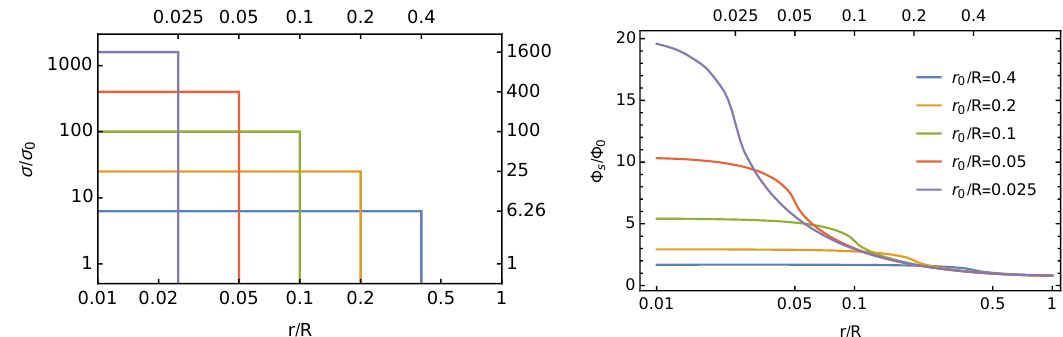
Figure 3. Scaled surface charge density σ ( r ) / σ 0 (left diagram) and scaled surface potential Φ s ( r ) / Φ 0 (right diagram) according to Equation (9), with l D = R and ε l = ε w . In both diagrams, the different curves correspond to r 0 / R = 0.4 (blue), r 0 / R = 0.2 (orange), r 0 / R = 0.1 (green), r 0 / R = 0.05 (red), and r 0 / R = 0.025